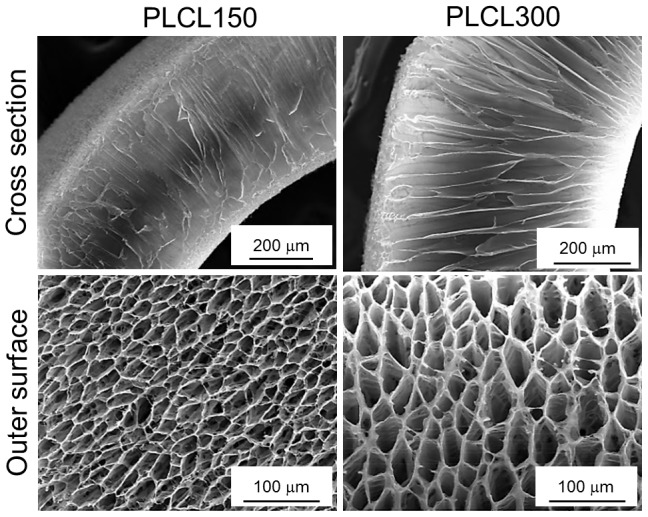
Influence of the polymer molecular weight.SEM images of the cross section and the outer surface of the foams prepared from PLCL solution (5% w/v, quenched at −80°C for 30 s) of variable molecular weights showed the well-organized pore morphology and increased overall foam thickness in PLCL300 (M
w = 316,000 g/mol and M
n = 120,000 g/mol) as compared to that of PLCL150 (M
w = 162,000 g/mol and M
n = 57,000 g/mol).